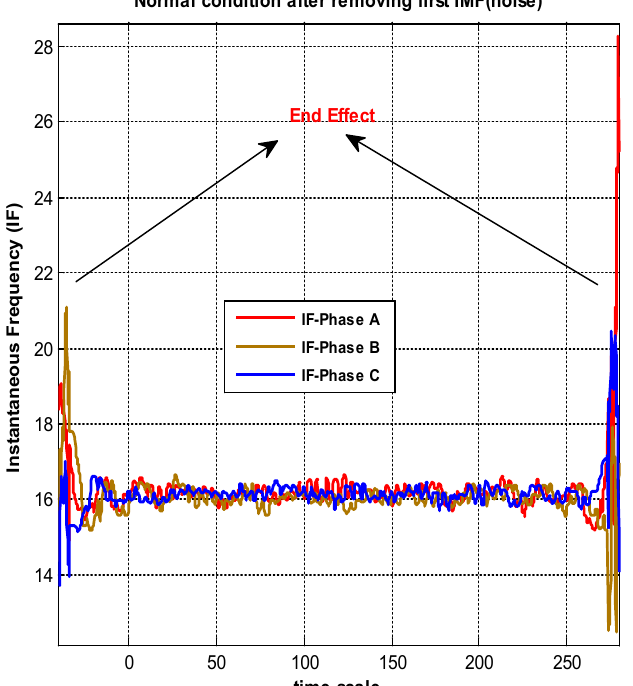
Fig. 12. IF corresponding to remove first imfs voltage sag condition of signal IF signal can use for separation for two cases but there is end effect problem that have to be solved. This is another future work of the study. When cubic spline fitting is computationally demanding, generates distortions near the end points. This is a technical problem that causes